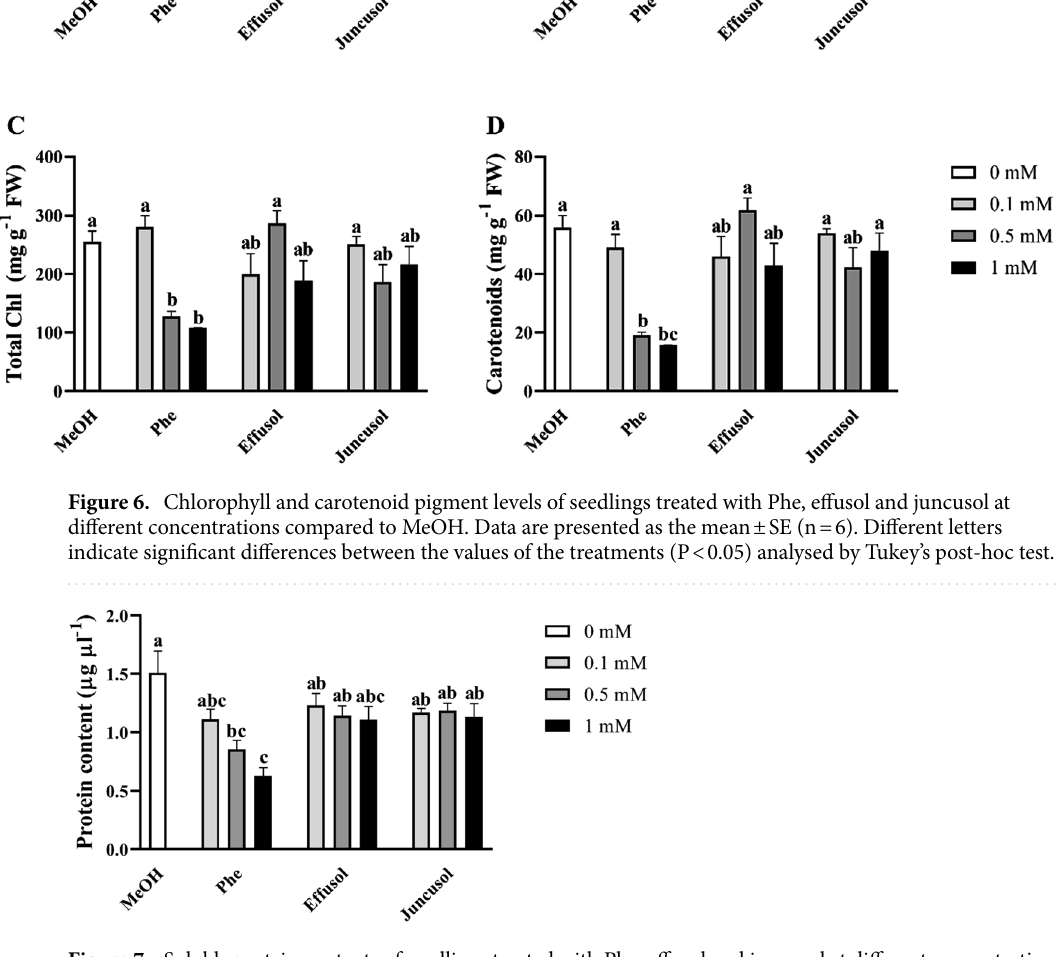
Figure 7. Soluble protein contents of seedlings treated with Phe, effusol and juncusol at different concentrations compared to MeOH. Data are presented as the mean ± SE (n = 6). Different letters indicate significant differences between the values of the treatments (P < 0.05) analysed by Tukey’s post-hoc